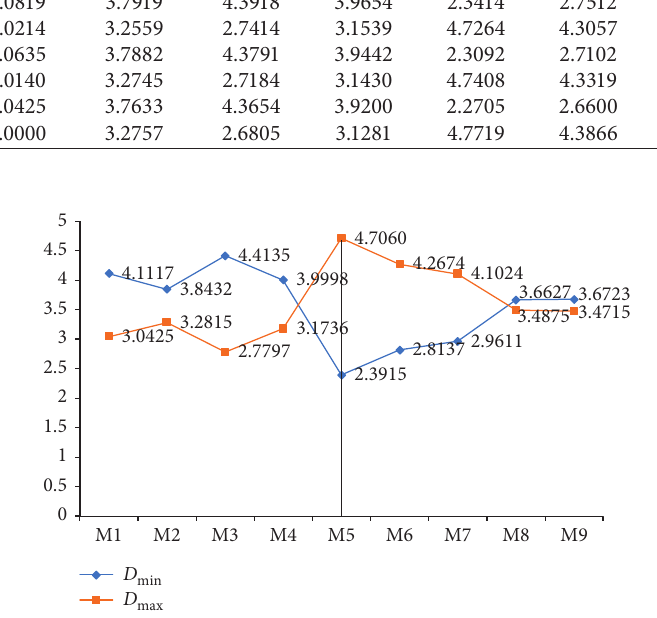
Figure 6: Visualization of the evaluation of module innovation resources at τ � 0.